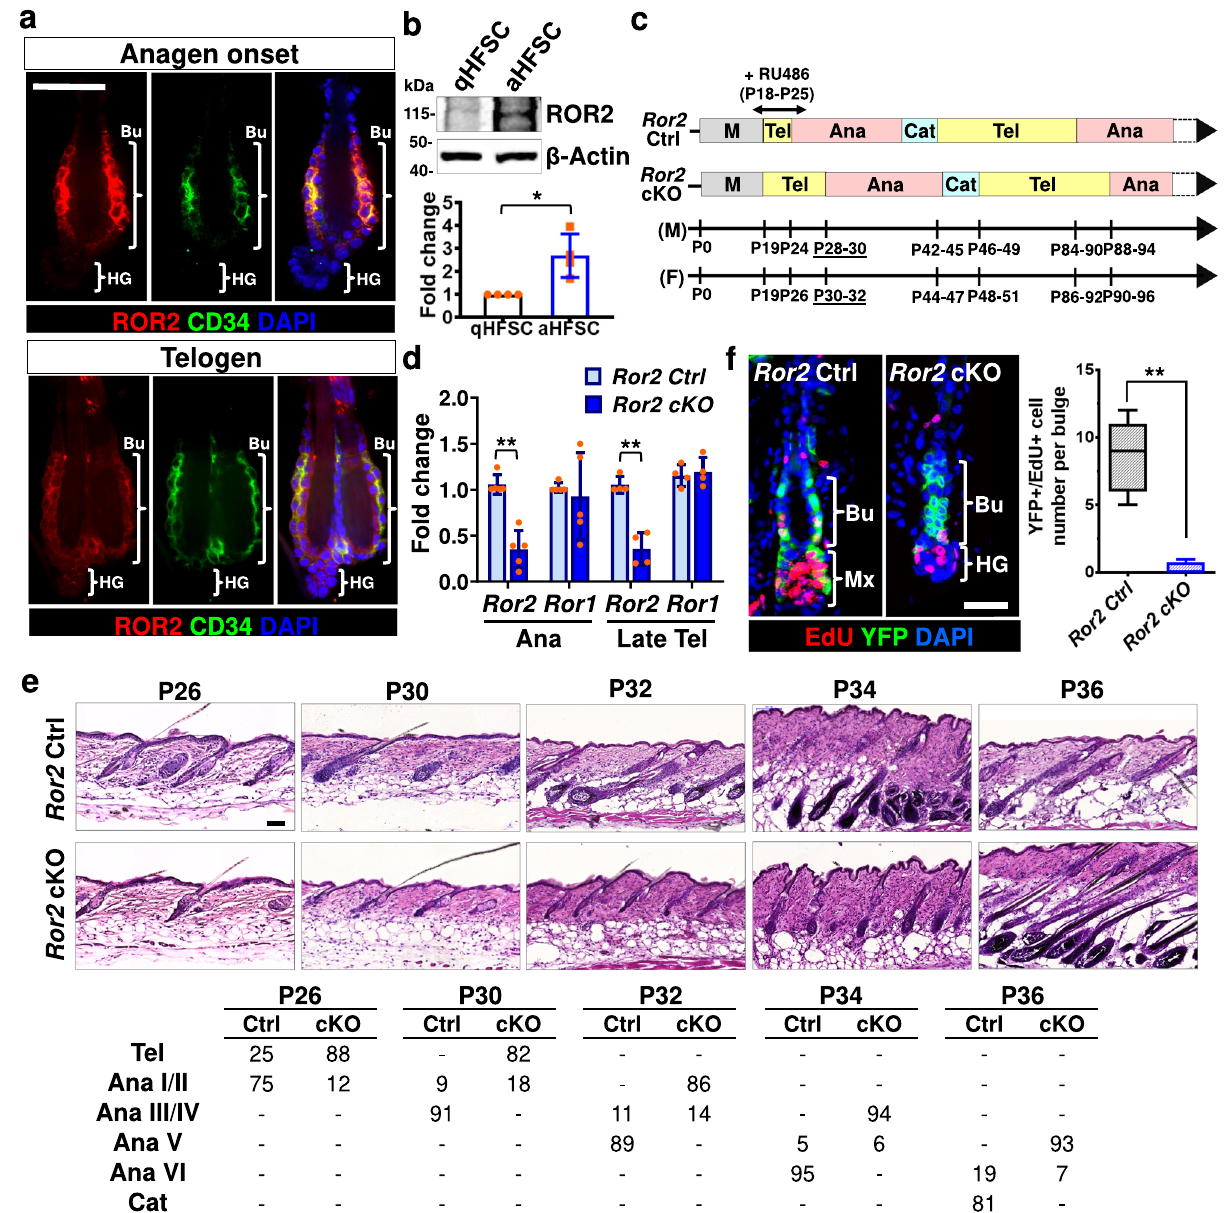
Fig. 1| Ror2 depletioninbulgecausesadelayof HFSC activationandhaircycle progression. a Whole-mount immuno fl uorescence staining of mouse HFs at anagen onset and telogen for ROR2 (red) and CD34 (green). Bu, bulge; HG, hair germ. b ROR2 expression is upregulated in activated HFSCs. Immunoblotting analyses of FACS-puri fi ed HFSCs from P55 (for quiescent HFSC; qHFSC) and P22- 23 (for activated HFSC; aHFSC) mouse back skins for ROR2 and β -Actin. Quanti- fi cation of ROR2 protein levels from independent experiments is shown as the graph below. Data were normalized to β -Actin. Values were calculated by com- paring to qHFSC and reported as average ± s.d.; n =4 blots from independent FACS-sorted HFSCs; * p =0.0117. c Schematic diagram illustrating delayed hair cycle entry in Ror2 cKO mice as compared to their Ctrl littermates. Mice were treated with RU486 to activate Cre recombinase in HFSCs at P18-25. M morpho- genesis, Tel telogen, Ana anagen, Cat catagen, M males, F females. d Real-time PCR analyses with FACS-puri fi ed Ror2 Ctrl and cKO HFSCs from anagen onset